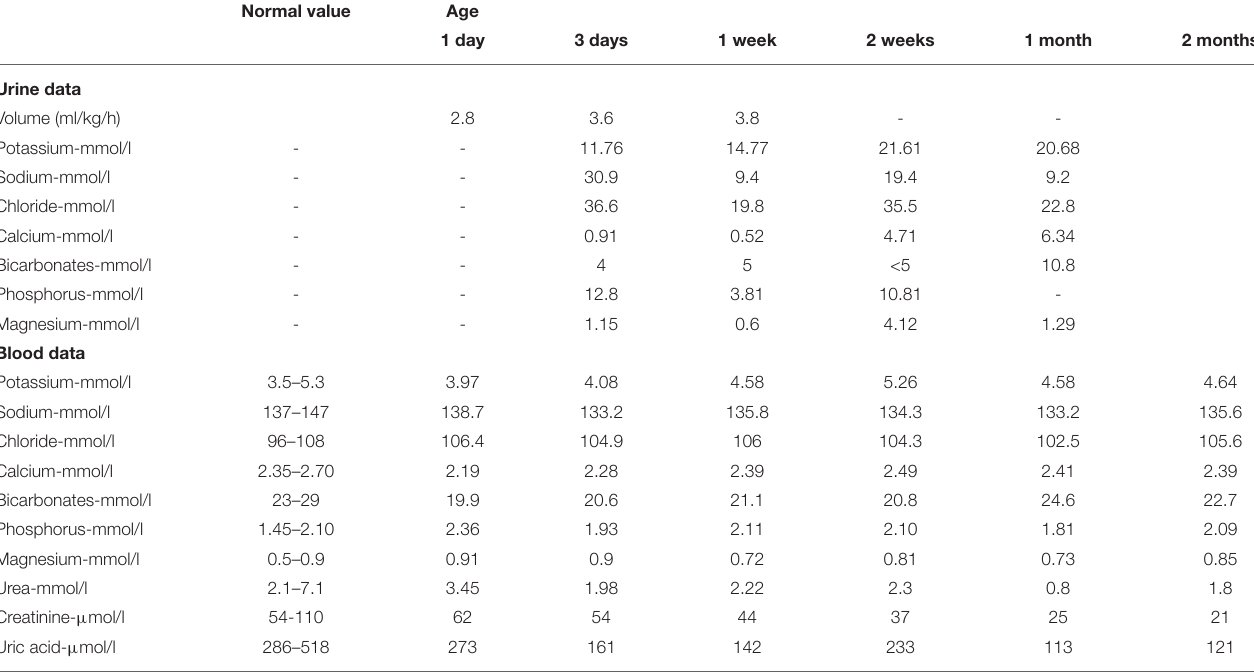
TABLE 1 | Postnatal biochemical data of neonatal with MAGED2